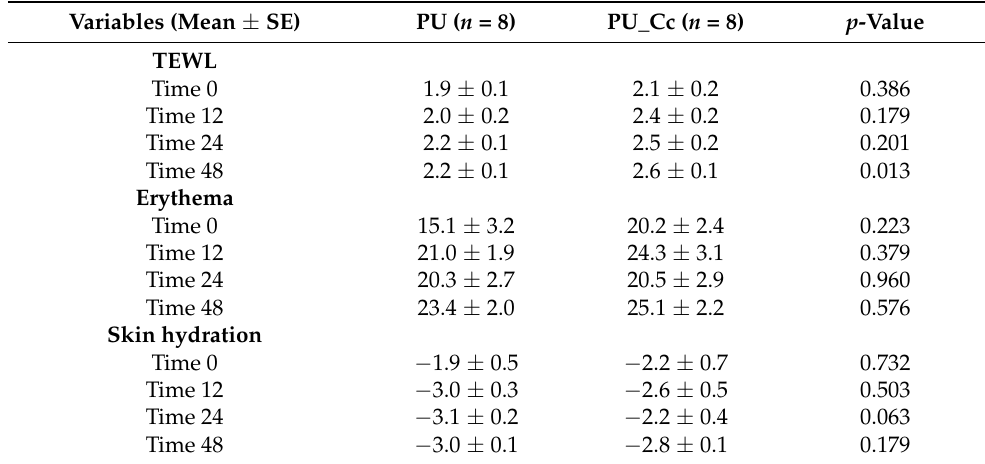
Figure 4. The evolution of the main skin parameters: ( a ) TEWL, ( b ) erythema, ( c ) skin hydration. Table 4. Medication dynamics measured among study